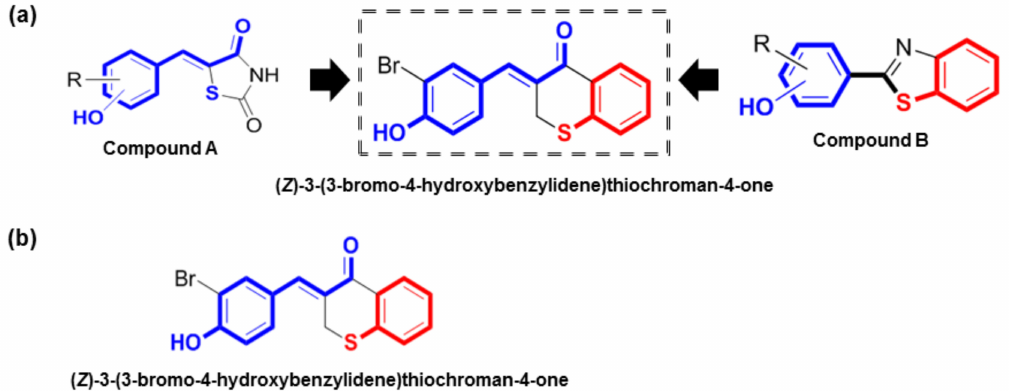
Figure 1. Rationale for the design and synthesis of ( Z )-3-(3-bromo-4-hydroxybenzylidene)thiochroman-4-one (MHY1498). ( a ) Rationale for the design of MHY1498; ( b ) chemical structure of ( Z